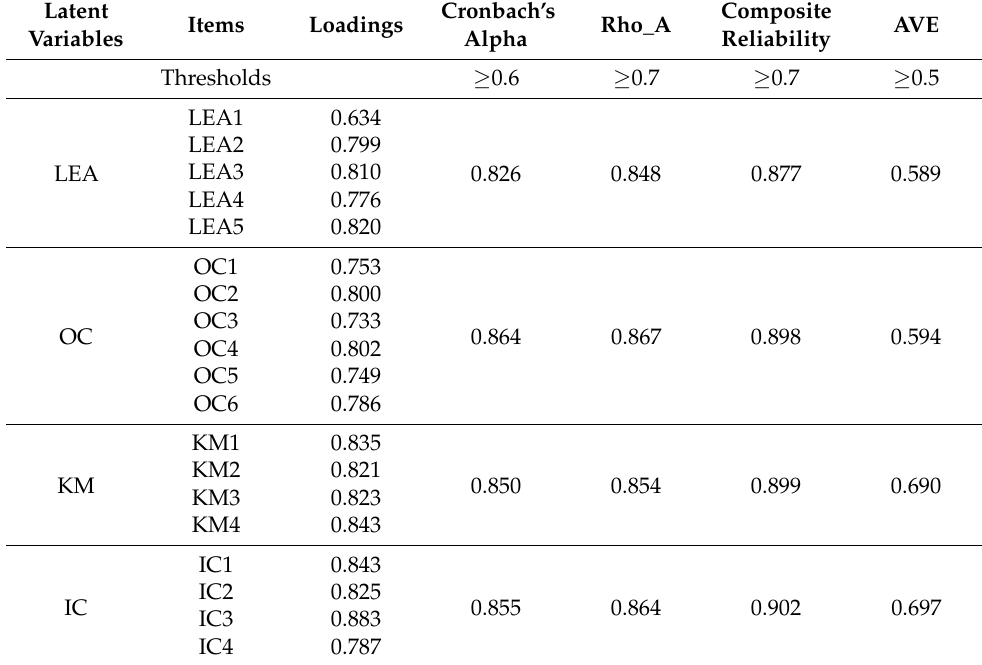
Table 3. Confirmatory Factor Analysis (CFA).